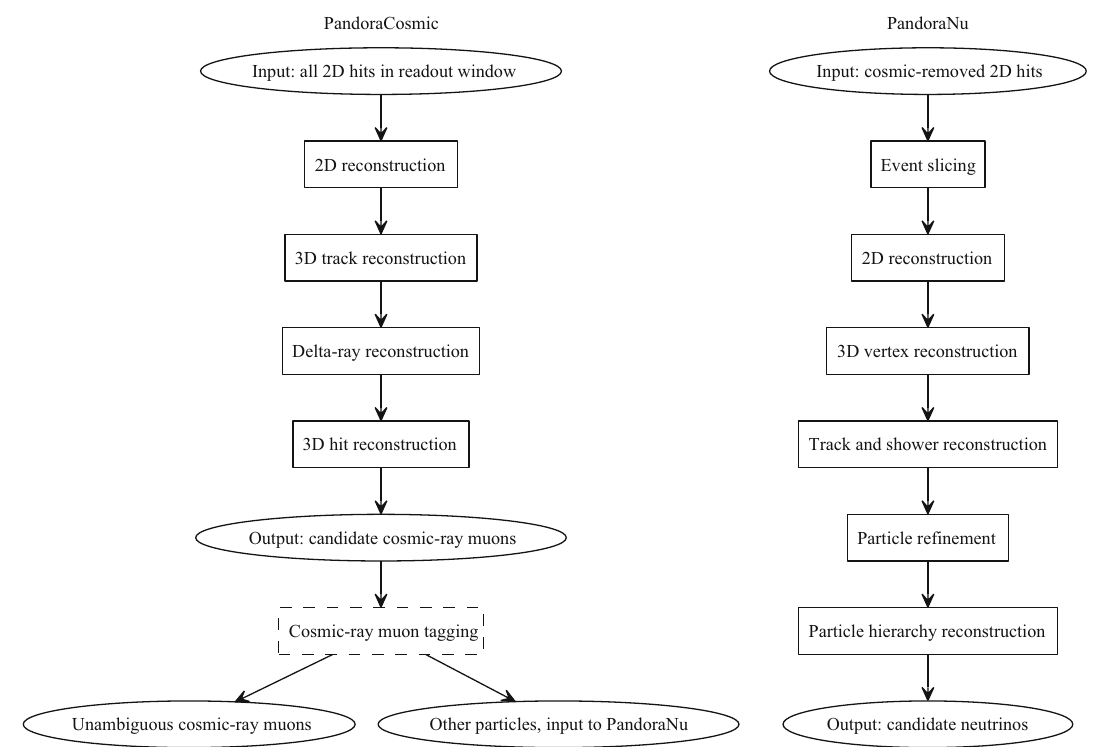
Fig. 2 A simple representation of the two multi-algorithm reconstruc- tion paths created for use in MicroBooNE. Particles formed by the Pan- doraCosmic reconstruction are examined by a cosmic-ray tagging mod-